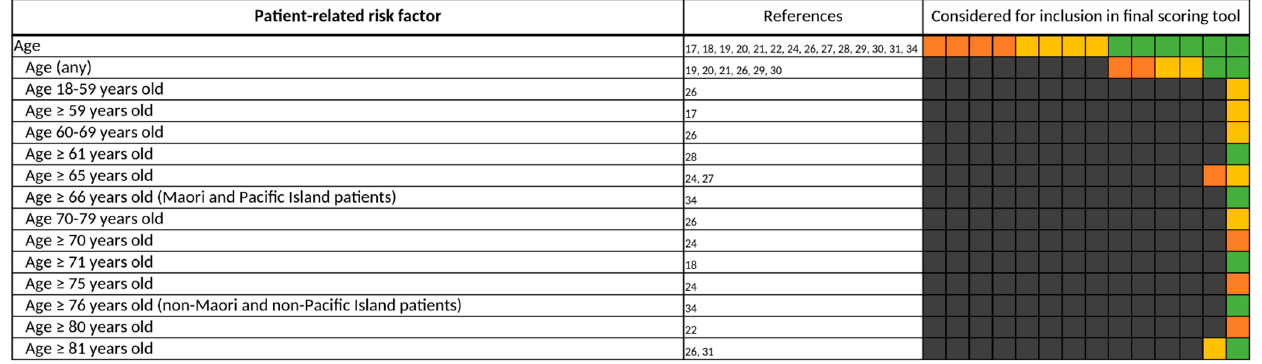
Figure 11. All different thresholds investigated by the authors of the included studies for “age”. Each of the 14 boxes represents one of the included studies. The color of the boxes portrays whether a risk factor was not investigated in a study (gray), was investigated (orange), was significant in a first statistical analysis or based on expert consensus and therefore tested for inclusion in a final scoring tool (yellow), or whether a risk factor was included in a final scoring tool (green). The “citations”-column lists each study that at least investigated the respective risk factor.